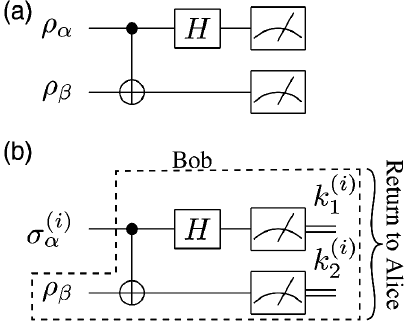
FIG. 15. (a) A simple comparator circuit. (b) A secure com- parator that uses our QFHE scheme. Here, σ ð copy of Alice ’ s qubit, ρ β is Bob ’ s qubit, and k ð classical measurement